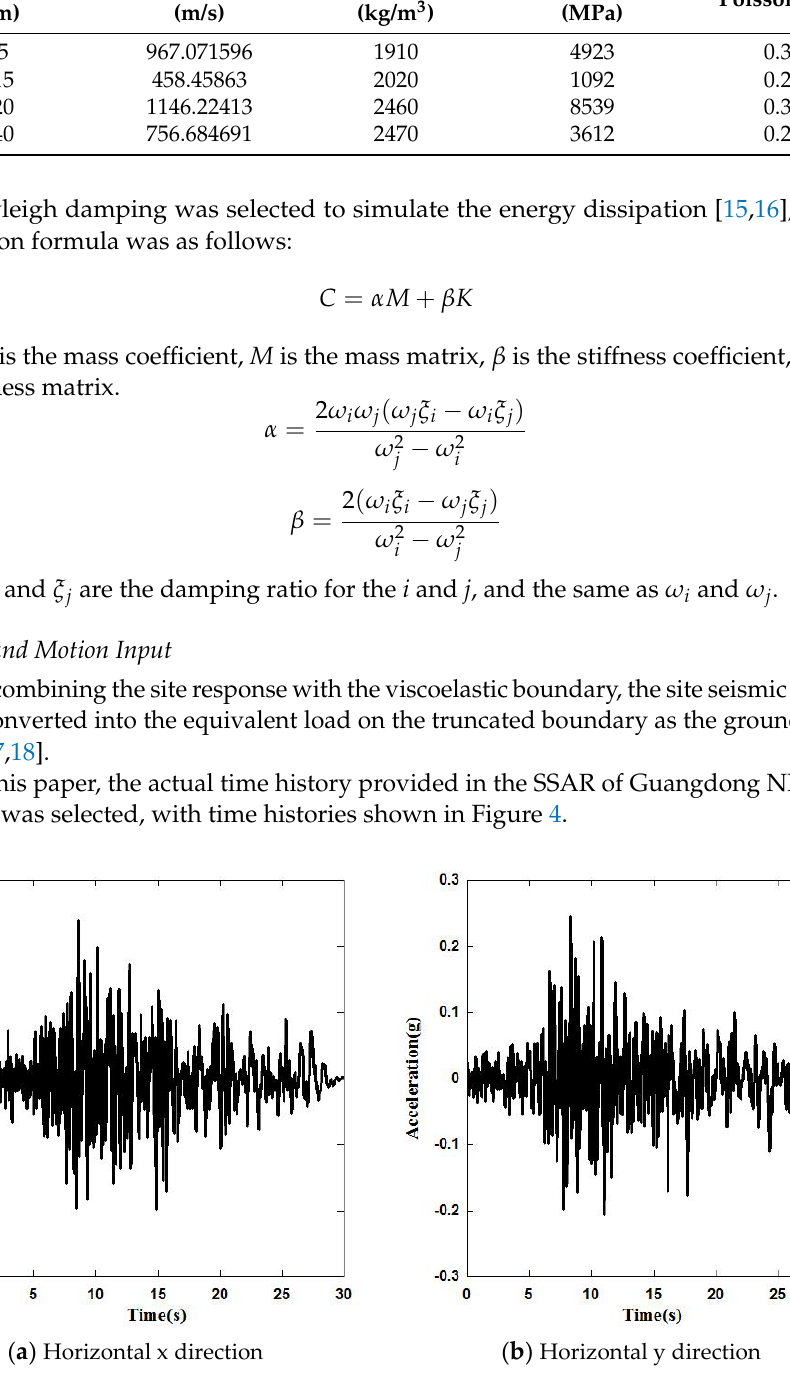
Figure 4. Time history of Guangdong NPP site.